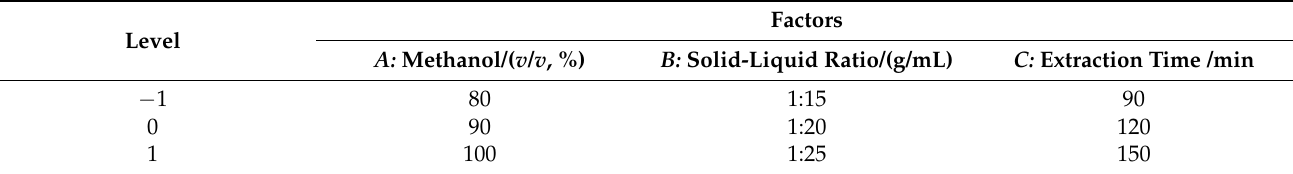
Table 1. Response surface optimization